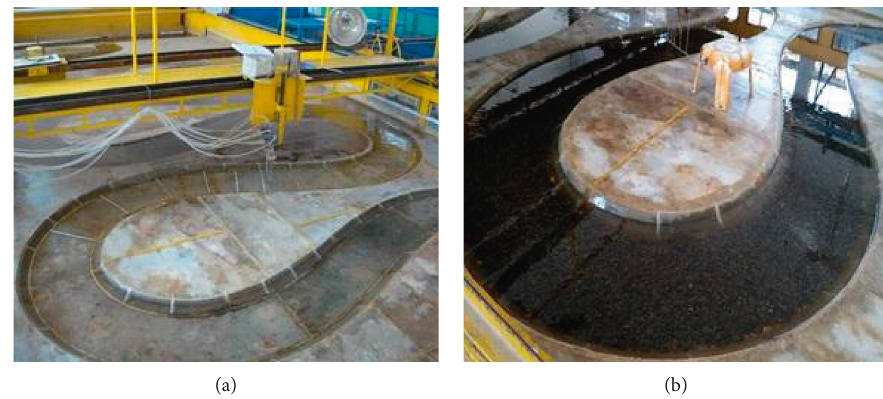
Figure 2: Experimental meandering channels: (a) smooth and (b)